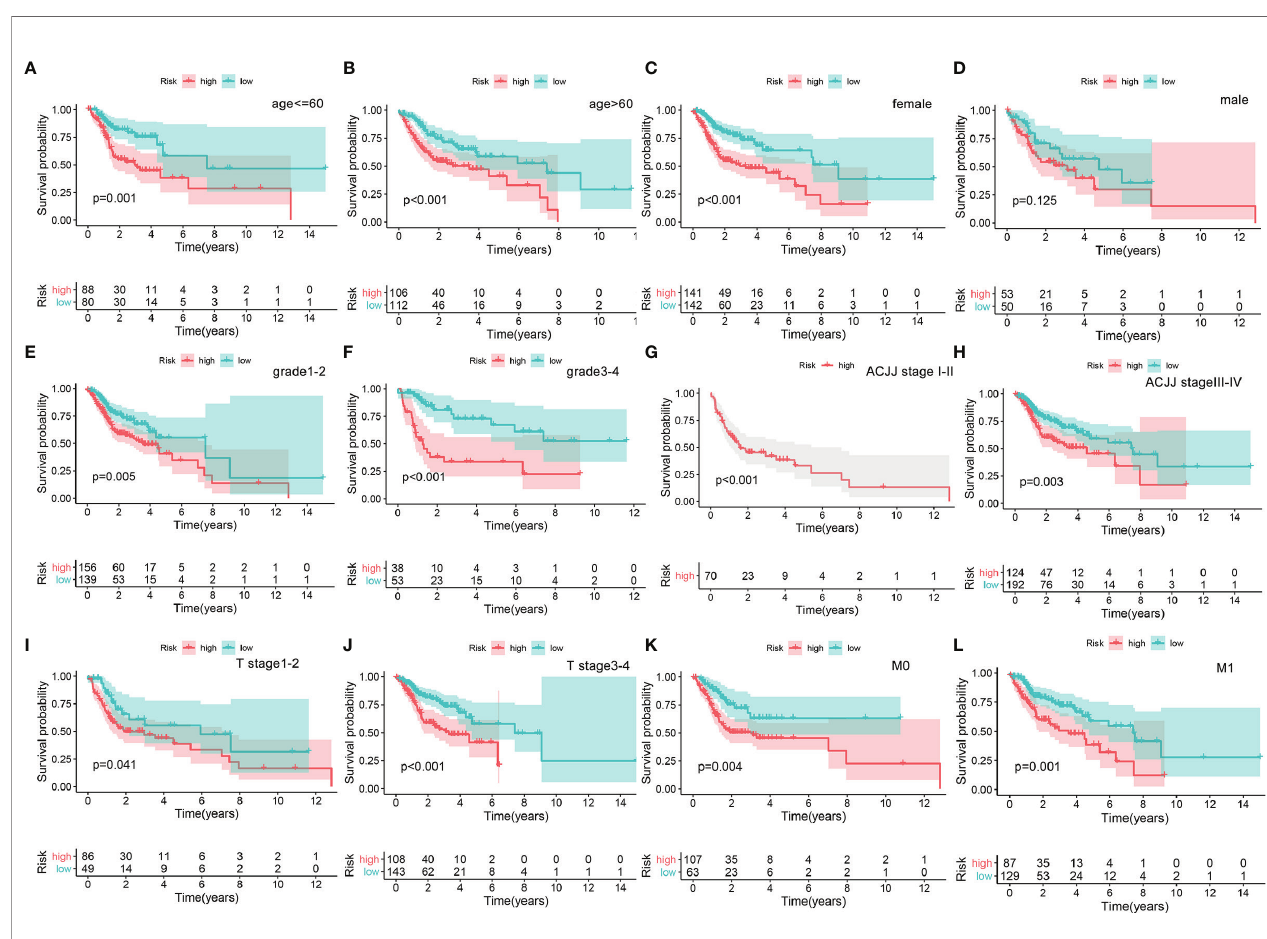
FIGURE 4 | Overall survival difference between high- and low-risk groups for HNSCC patients strati fi ed by clinical parameters, including age [age ≤ 60, ag e>60, (A, B) ], gender [female, male, (C, D) ], grade [G1 – 2, G3 – 4, (E, F) ], AJCC stage [Stage I – II, Stage III – IV, (G, H) ], T stage [Stage 1 – 2, Stage 3 – 4, (I, J) ], and M stage [M0, M1, (K, L)